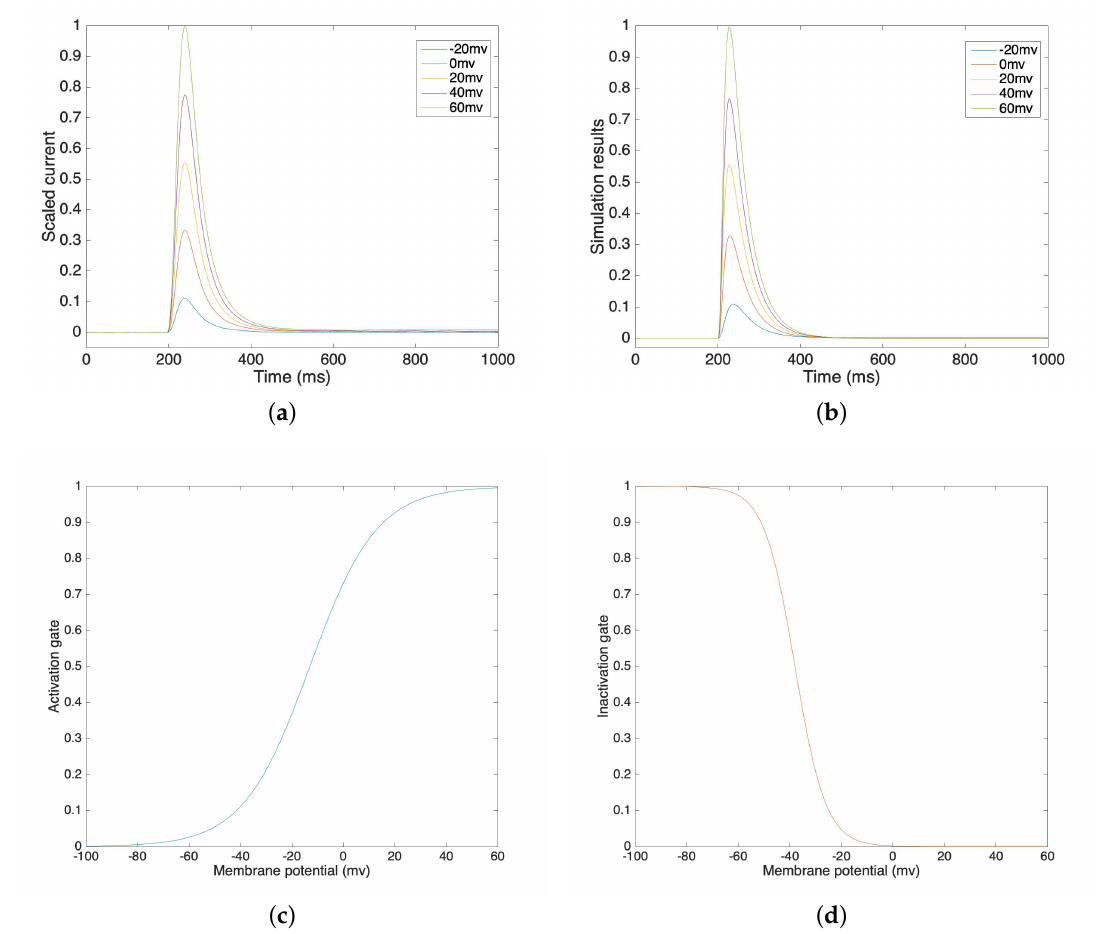
Figure 2. ( a ) Voltage clamp potassium channel lab data at voltage steps of − 20 mV to 60 mV. ( b ) Voltage clamp potassium channel simulation result at voltage steps of − 20 mV to 60 mV. ( c ) Simulated activation gate variable. ( d ) Simulated inactivation gate